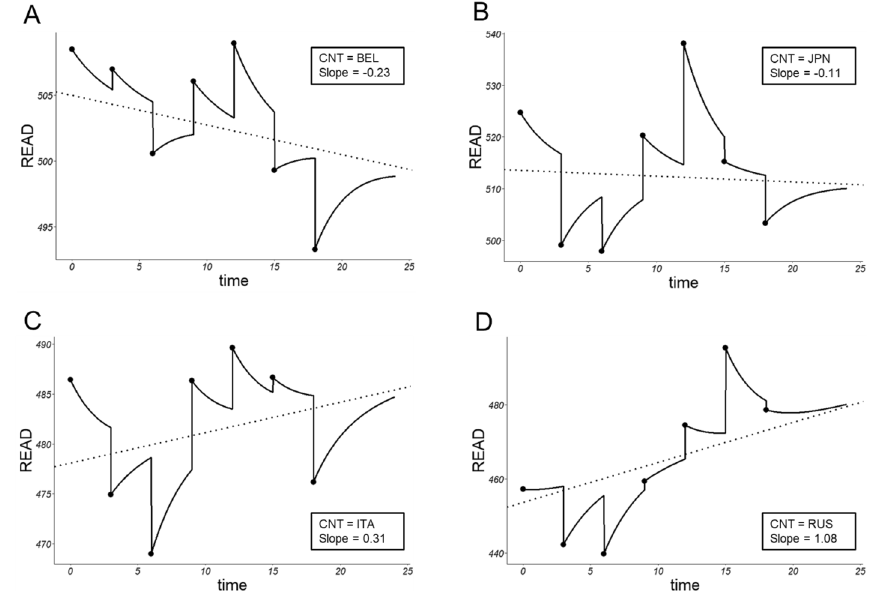
Fig. 6 Model implied expected trajectories given past observations of four PISA countries’ mean reading literacy score development. CNT country code, Slope country specific growth rate (dotted lines). The = = solid black line represents the expected model implied trajectory given past observations for a respective country. The predictions are a combination of both process components (linear trend and dynamics; cf. Eq. 8, 9). The slope parameter estimates are obtained from the trend component of the CT-LCM-SR and are represented by the dotted lines. The deviations from the trend and the subsequent carry-over effects are described by the dynamic component of the